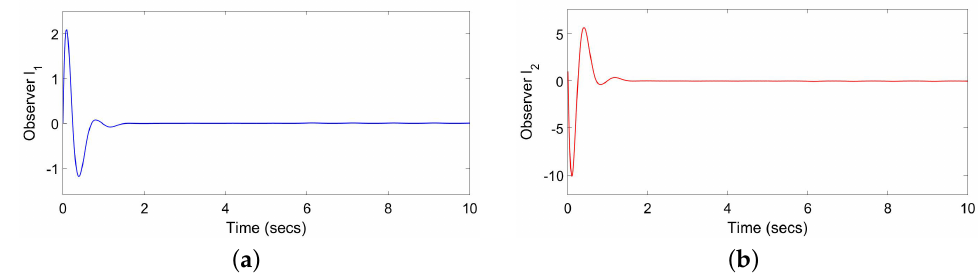
Figure 3. ( a ) State l 1 under probabilistic gain controller; ( b ) state l 2 under probabilistic gain controller.